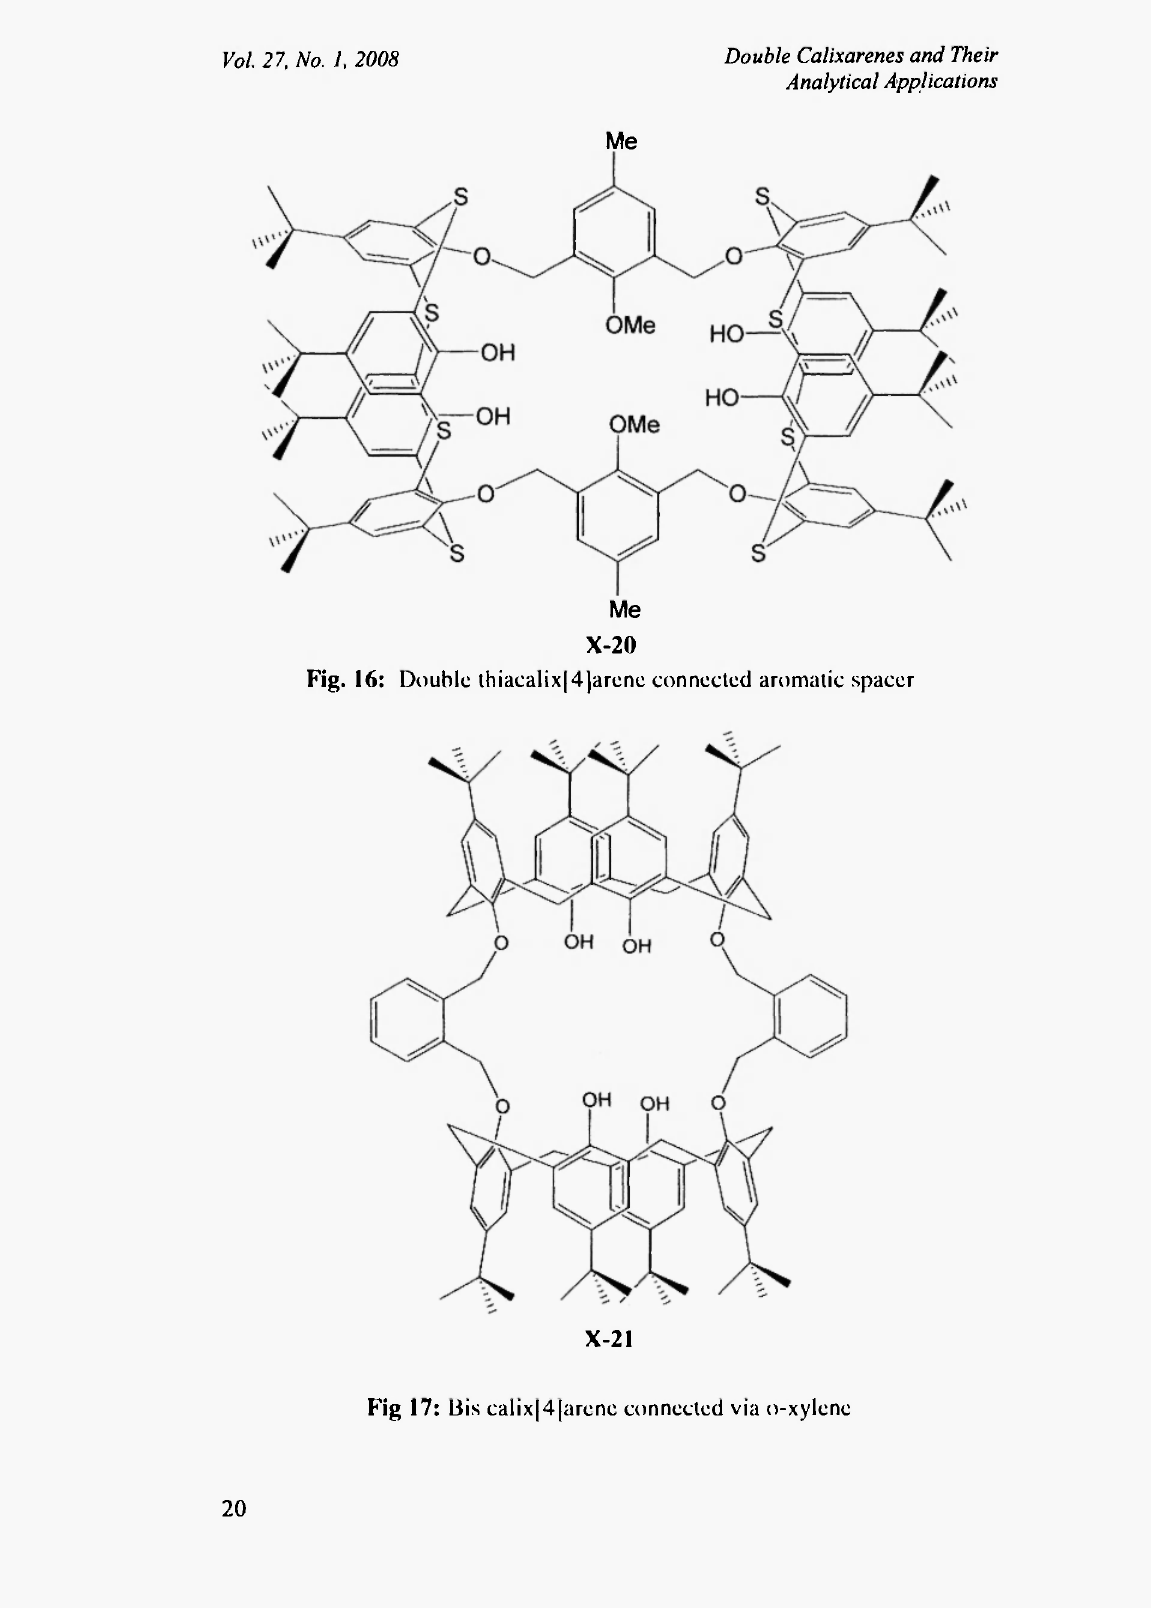
Fig 17: Bis calix|4|arenc connected via